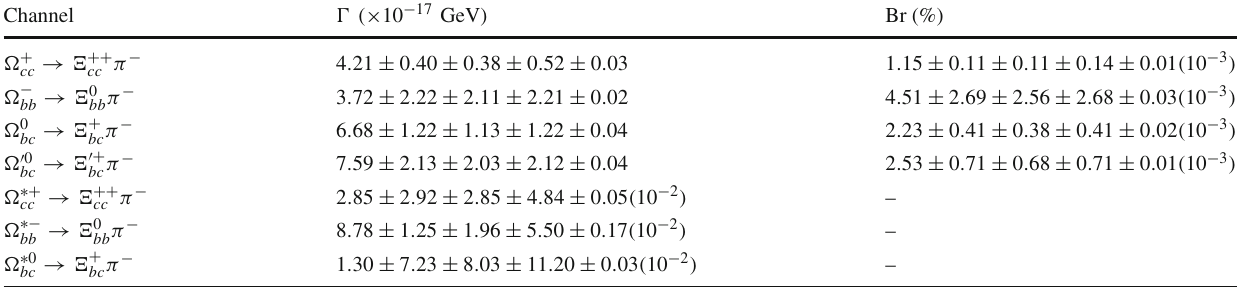
Table 9 Numerical results of decay width and branching fraction in doubly heavy baryon nonleptonic decays using F(0)